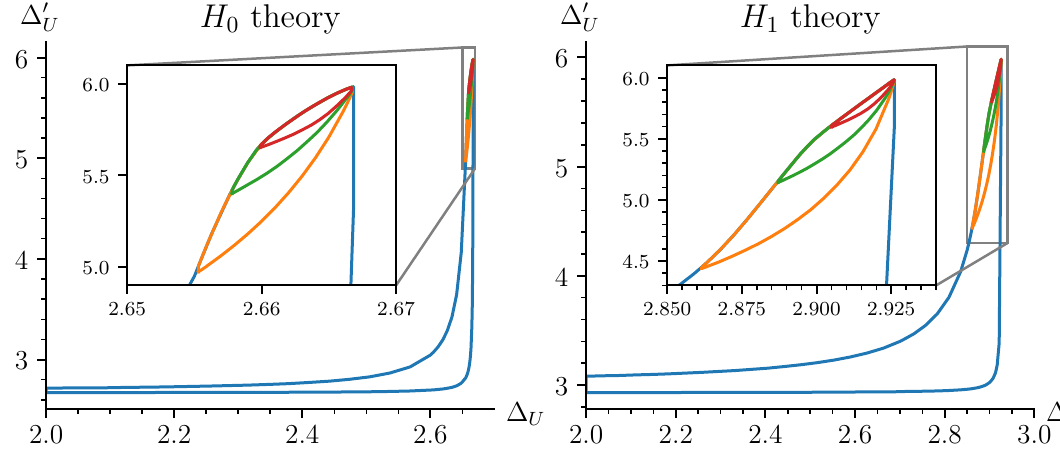
Figure 3 . Dimensions ∆ U versus ∆ 0 of the two lowest dimension unprotected operators in the U ϕ × ¯ ϕ channel. We fix the dimension of the external operator ϕ and the central charge c , and impose a gap with the next operator in the spectrum ∆ 00 ≥ 6 , 7 , 8 , 9 . For ∆ 00 greater than 7 we provide U U a zoom to the allowed region, which form small islands isolated from the continuum. All bounds have been obtained with cutoff Λ = 32